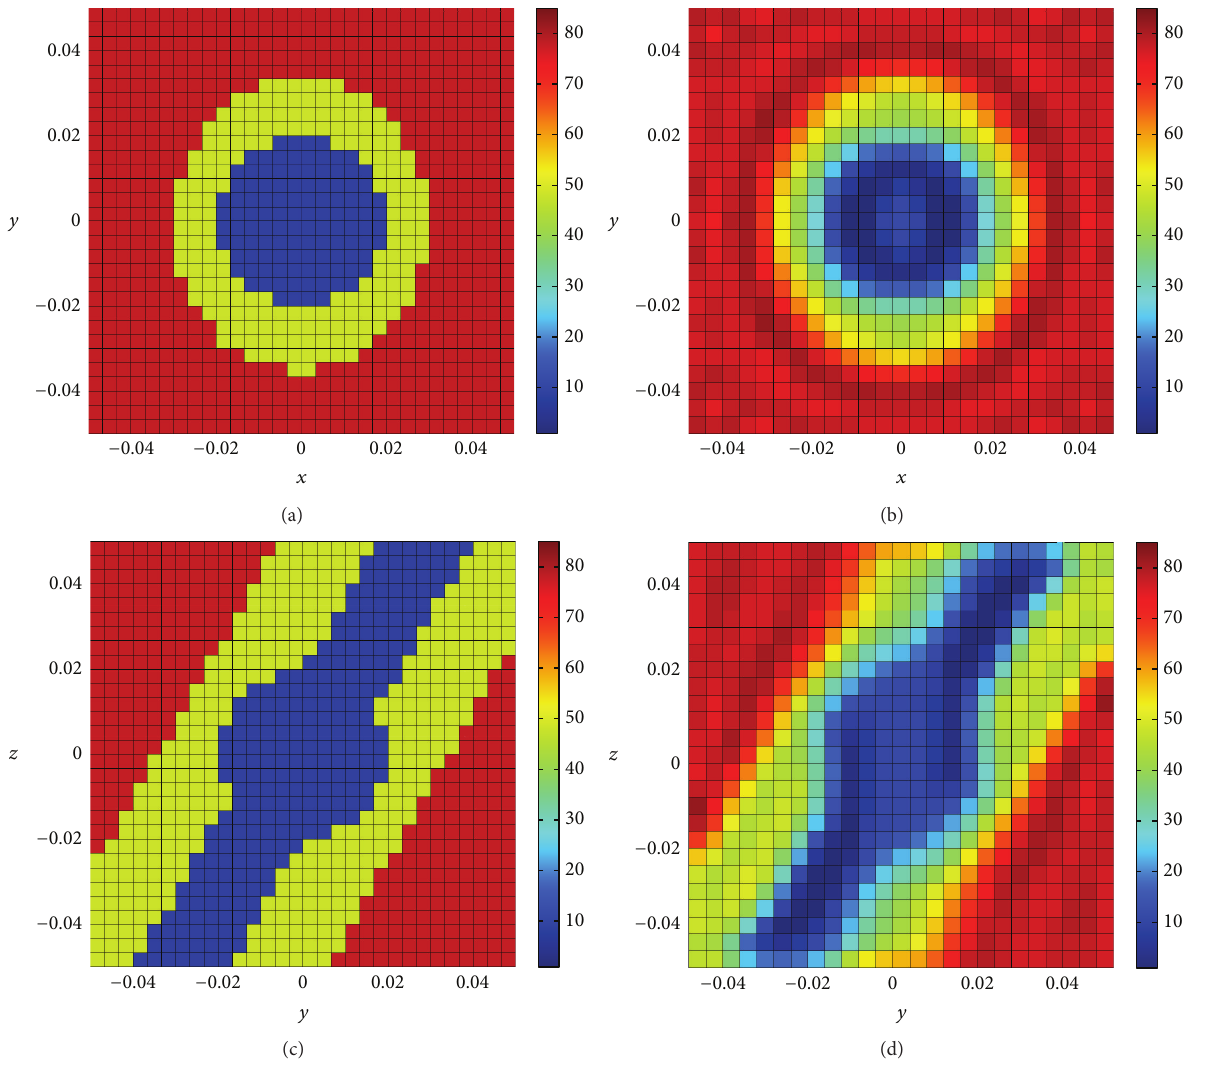
Figure 8: Real part of the exact permittivity used to simulate the data at 1GHz without added noise (left) and of the reconstructed permittivity on the coarser grid (right) for the child’s arm phantom, in the 𝑥𝑦 -plane (top) and 𝑦𝑧 -plane (bottom). Distances are in m.